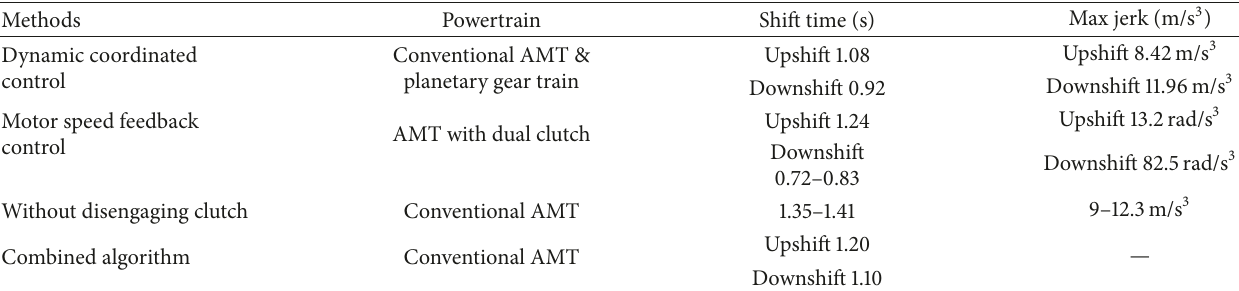
Table 3: Upshift and downshift on-board experiments